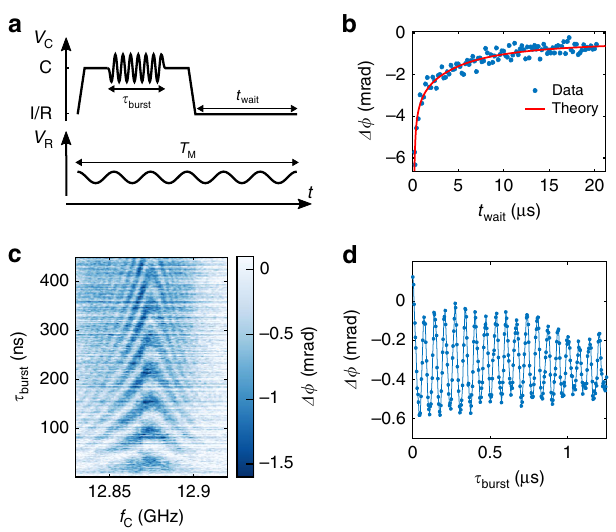
Fig. 4 Single spin control and dispersive sensing. a The pulse sequence alternating between “ deep ” (1, 1) regime (C) for spin manipulation and “ shallow ” (1, 1) regime (I/R), close to the (0, 2) ↔ (1, 1) transition, for the readout and resetting of the spin system. A microwave burst rotates the hole spin during the manipulation stage. The readout tone is continuously applied throughout the sequence period T M . b Phase shift as a function of t wait for a ≃ 1 mV pulse on V C with τ burst = 100 ns and f C = 12.865GHz, with B = 0.512 T along β = 0° and θ = 60°. The phase signal approaches 0 when t wait ≫ T 1 . A simple model yields T 1 = 2.7 ± 0.7 μ s. c Dispersive signal Δ ϕ ( f C , τ burst ), measured with the detuning pulses of a ) with t wait = 1 μ s. Four maps have been averaged. d Phase response as a function of EDSR burst time at f C = 12.865 GHz. The plot shows Rabi oscillations with 15 MHz frequency due to coherent spin rotations. Each data point is integrated for 100 ms and then averaged over 30 clear decay of the dispersive signal is observed, which suggests a spin lifetime at manipulation point longer than 10 μ s.